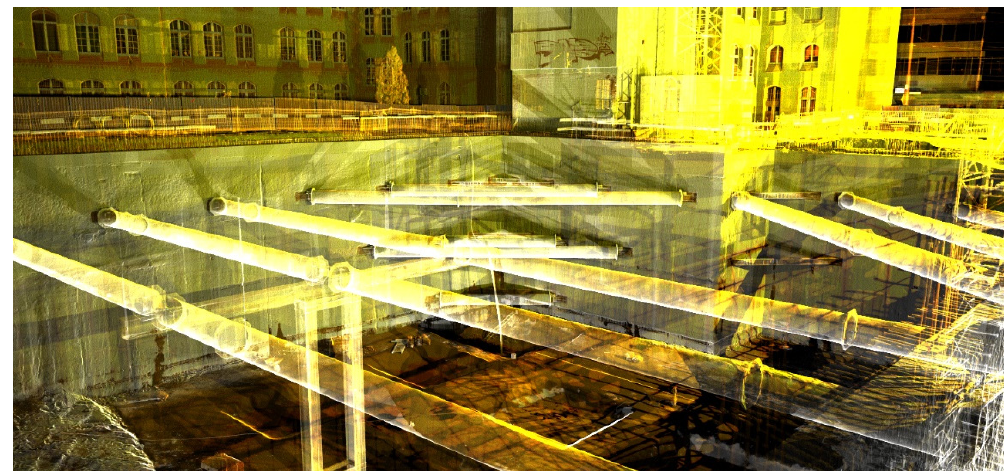
Figure A3. The view of point cloud after processing.